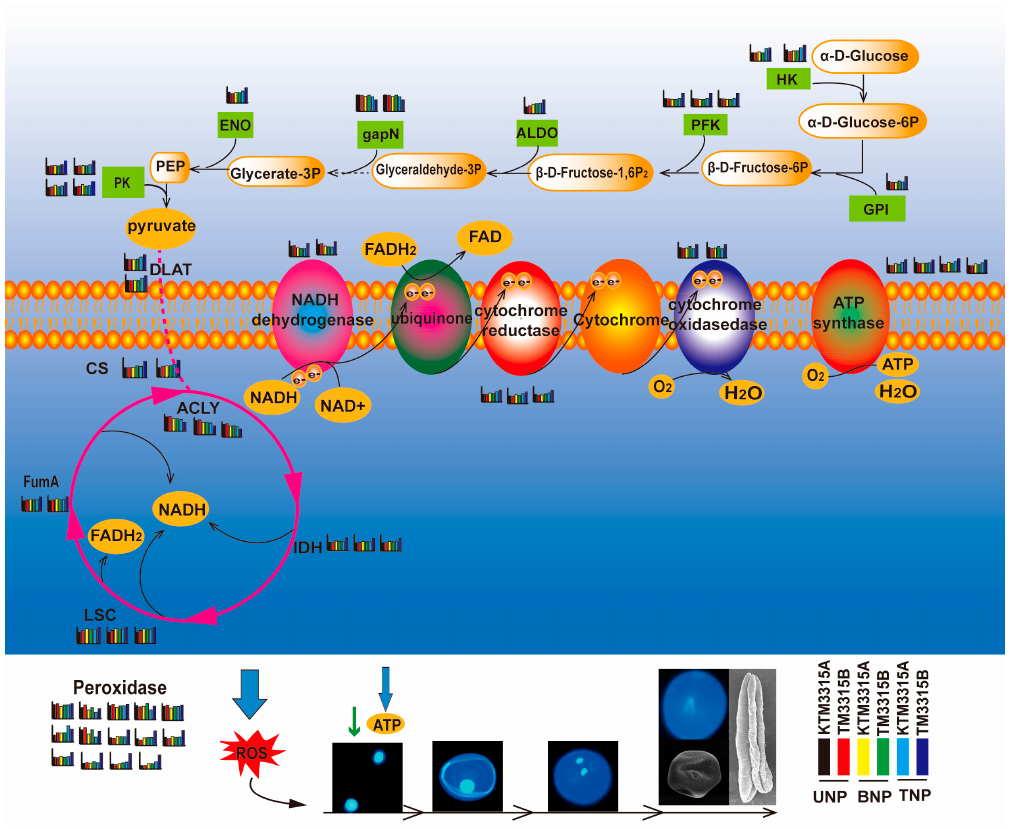
Figure 11. Possible protein network responsible for controlling male sterility in wheat. Histograms and numbers represent the protein identifications and abundance levels given in Supplementary Table S7. CS, citrate synthase; ACLY, ATP citrate (pro-S)-lyase; IDH, isocitrate dehydrogenase;